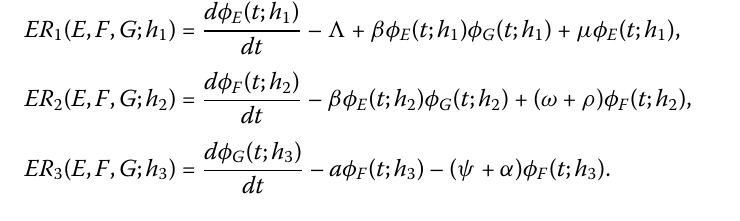
Figure 6 The h -curves of F (cid:10) (0) obtained by 6th-order approximation of the